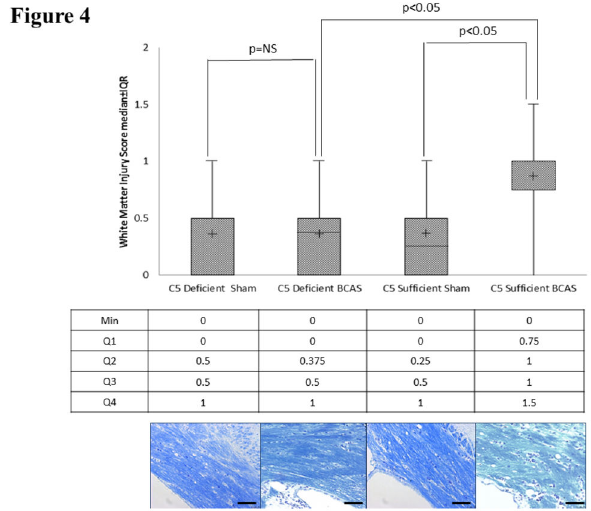
Figure 4. White matter ischemia. Kluver-Barrera staining for white matter ischemic changes in the medial corpus callosum in C5 sufficient and C5 deficient mice subjected to sham and BCAS operations. Above: White matter injury scores. Middle line is the median. The (+) is the mean. The upper and lower lines on the box are the 75% and 25%, respectively. The uppermost and lowermost bars are minimum and maximum, respectively. Values in the text are expressed as median and interquartile range Below: Representative coronal sections of the right corpus callosum with high magnification insert (medial corpus callosum). Bars indicate 50µm. n=10 C5D/ BCAS, n=10 C5D/ sham, n=9 C5S/ BCAS, n=9 C5S/ sham.